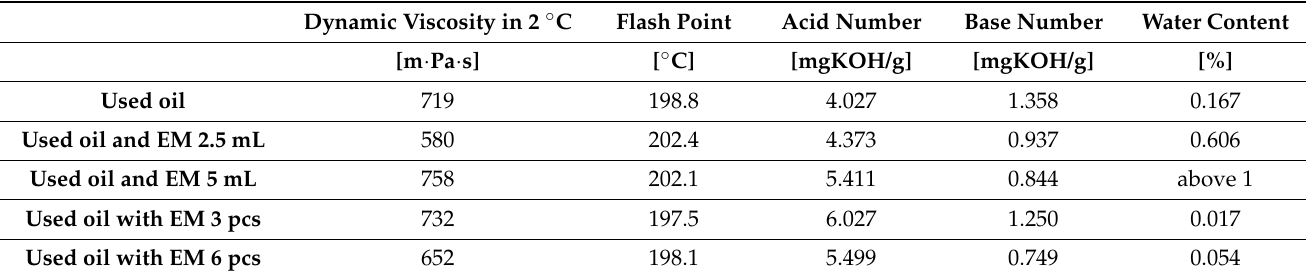
Table 4. Comparison of the parameters of used oil without additives with waste oil with effective microorganisms.